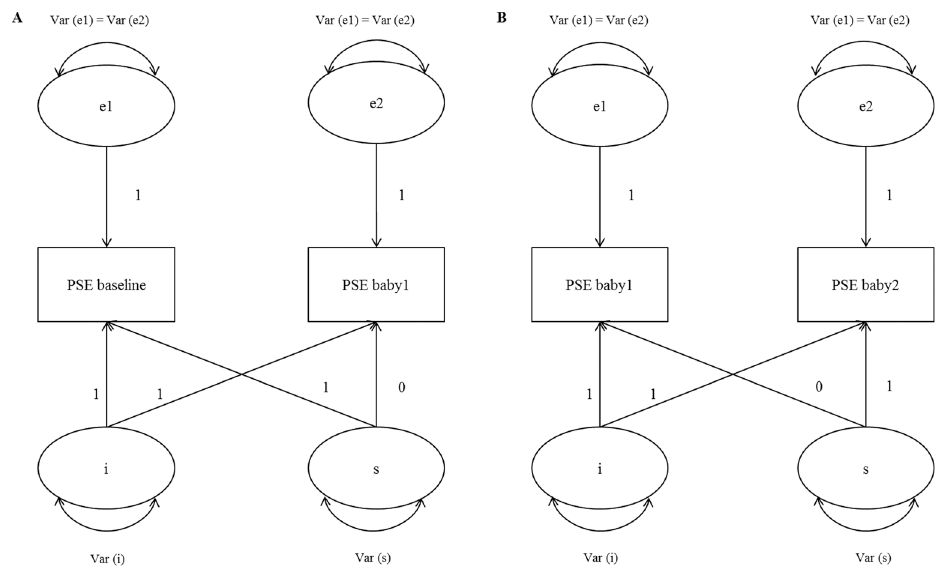
Fig 1. Fitted latent growth curve models for PSE during the Cry Response Task. (A) Model 1: Changes in PSE from baseline to baby 1. (B) Model 2: Changes in PSE from baby1 to baby2. PSE = Parenting Self- Efficacy; Var = variance; i = intercept; s = slope; e1 and e2 = residuals.